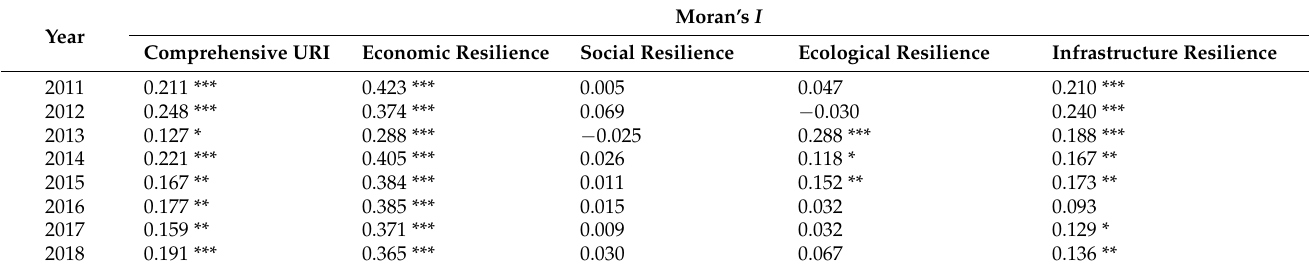
Table 2. The Moran’s I Index of URI in the